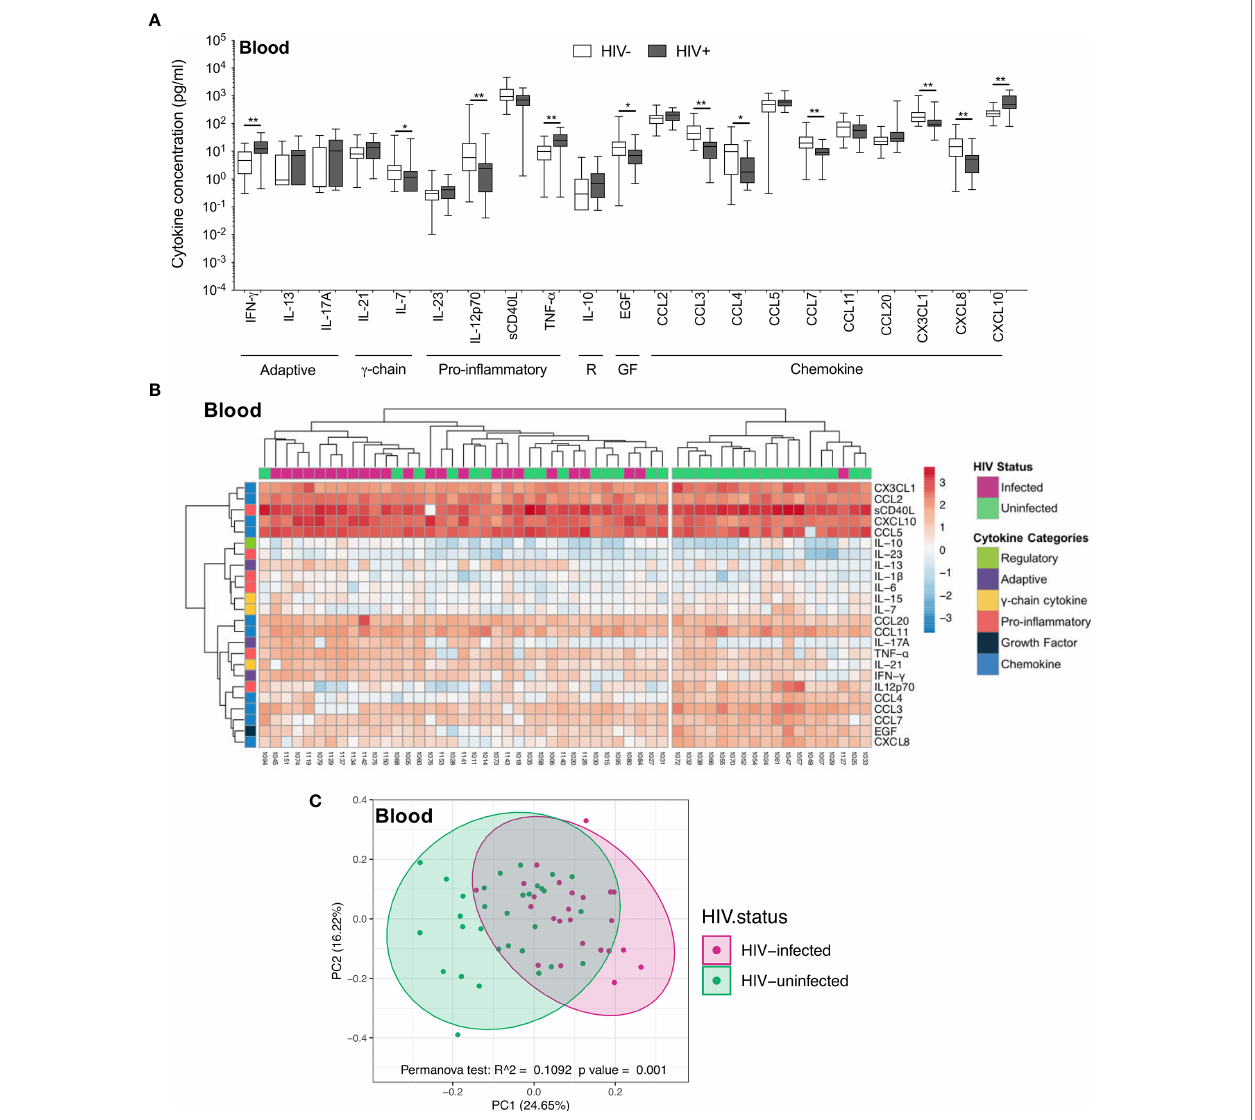
FIGURE 3 | Soluble immune mediators in blood in HIV-infected and uninfected individuals. (A) Box and whisker plots (min-max) comparing cytokine concentrations in plasma according to HIV status. “ R ” refers to regulatory cytokines and “ GF ” refers to growth factors. Statistical analyses were performed using a non-parametric Mann-Whitney U test with False Discovery Rate (FDR) step down correction. (B) Unsupervised hierarchical clustering of cytokines in blood. (C) Principal component analysis and permutational multivariate analysis of variance (permANOVA) of soluble immune mediators in HIV-infected (pink; n=24) and uninfected (green; n=31) participants. GM-CSF, IL-15, IL-1 b , IL-22, IL-4 and IL-6 were excluded as they were below the level of detection. The p values, p ≤ 0.05, p ≤ 0.01, p ≤ 0.001, p ≤ 0.0001 are reported as *, **, *** and ****, Figure 5B and data not shown). CD8+CD38+ T cells also correlated signi fi cantly between compartments, but only in HIV-infected individuals (p=0.002, r=0.762; Figure 5C ). There was no association between T cell activation and BAL or plasma viral load (data not shown).